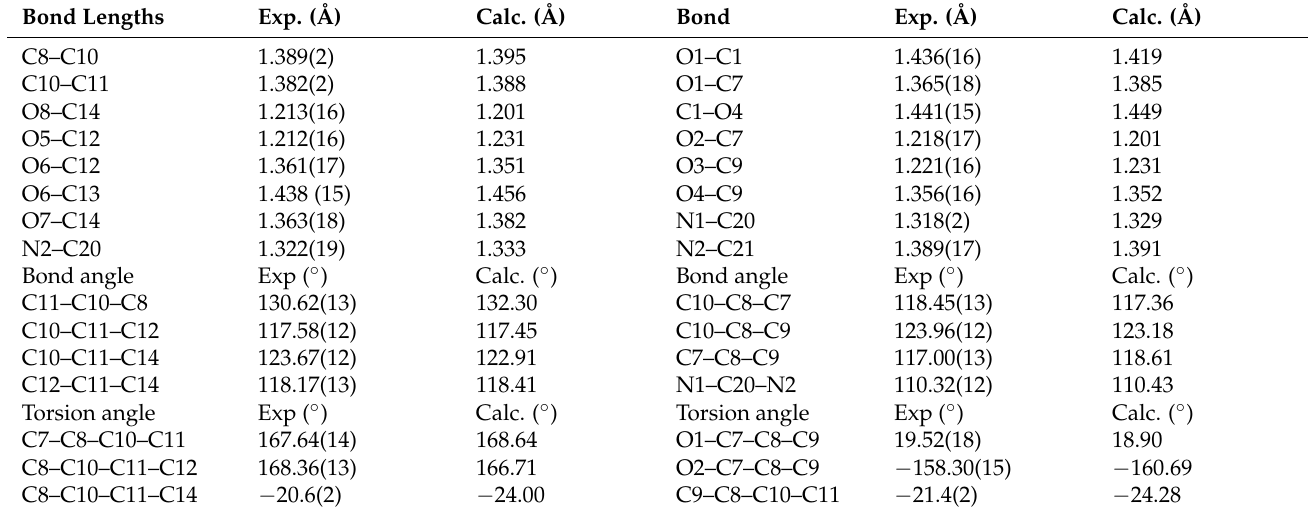
Table 2. Experimental and Computational Bond Distances (Å), Bond Angles ( ◦ ) and Torsion Angles for DBH .